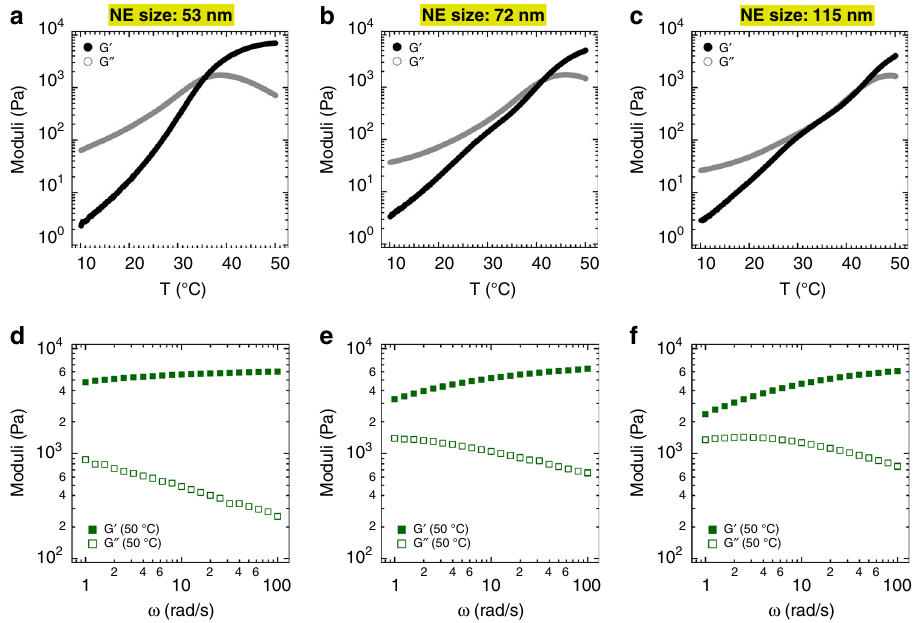
Fig. 4 Effect of nanoemulsion (NE) droplet size on rheological properties and gelation temperature T gel . Shear moduli as a function of temperature and frequency at 50 °C. The top panels show the evolution of the dynamic moduli in a small amplitude oscillatory shear temperature ramp experiment for thermogelling nanoemulsion with hydrodynamic diameters of a 53 nm, b 72 nm, and c 115 nm. Bottom panels d – f show the frequency sweep test at 50 °C for the same systems (applied strain amplitude is 0.1%). All systems contain the same volume fraction of oil droplets ( ϕ = 0.24) and chemical composition as the canonical system introduced in Fig. 2; 20% isopropyl myristate as an oil phase, 20% surfactant as an emulsi fi er (a mixture of Tween 80 and Span 80 with HLB = 13), 5% PEG 400, 4.7% Pluronic (F127/F68: 6/1 g/g), and 50.3% DI water. All concentrations are in mass